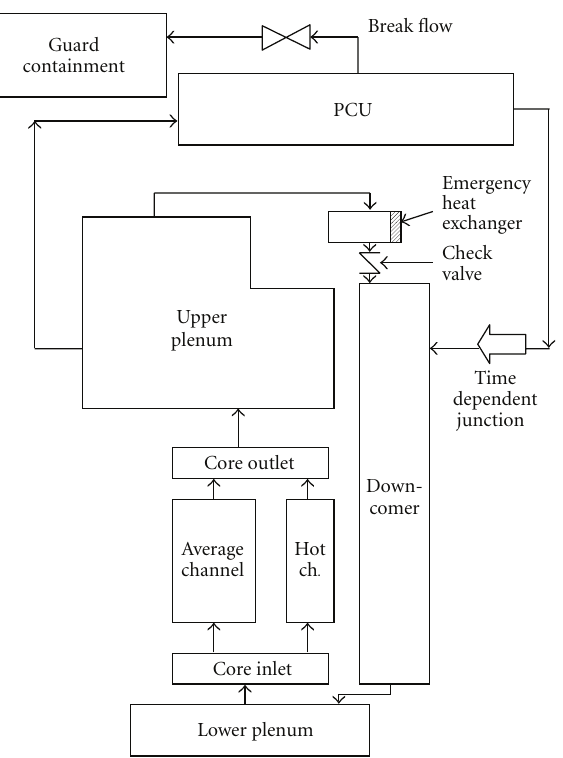
Figure 1: RELAP5 model of the GFR